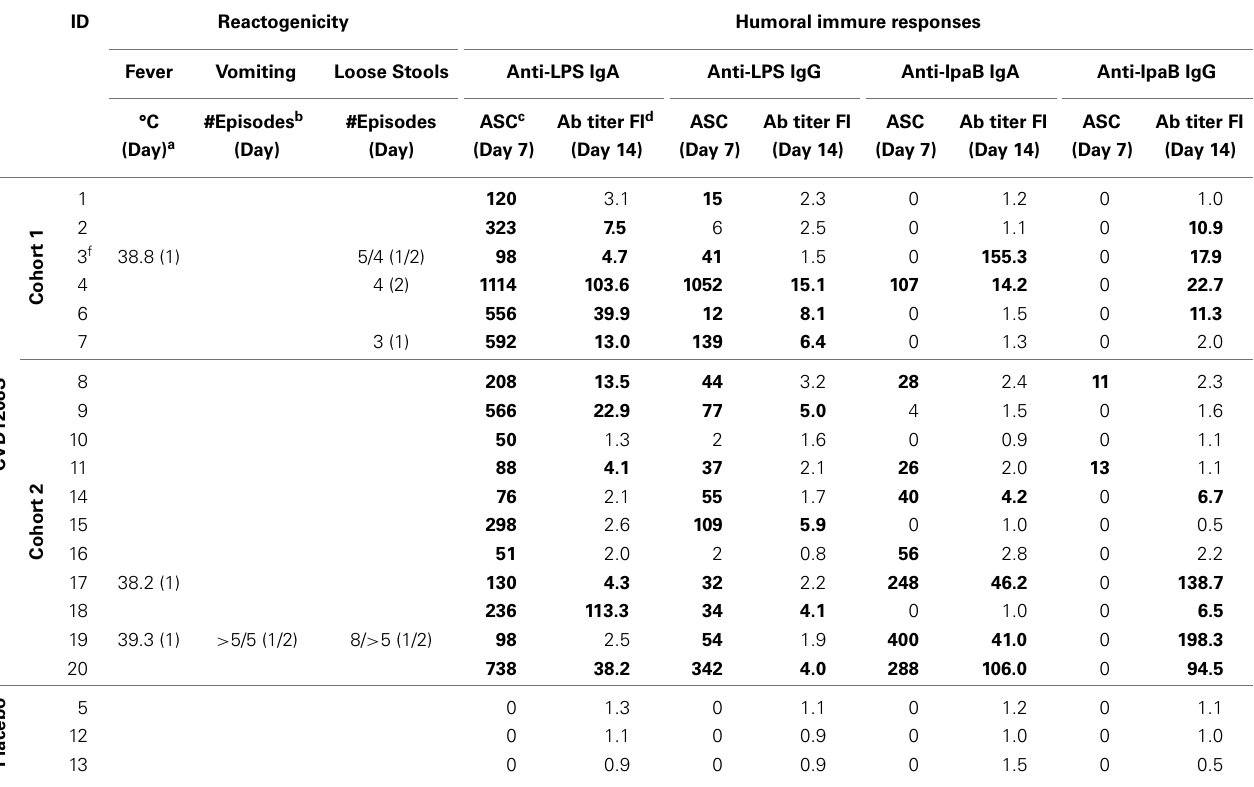
Table 2 | Reactogenicity and humoral responses in vaccinated volunteers and placebo controls